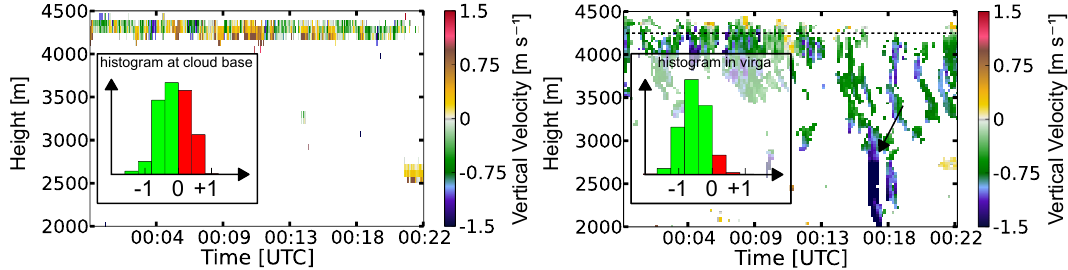
Figure 3. Vertical velocity for case 1. Left: derived from lidar (valid for more numerous smaller droplets at cloud base); right: derived from radar observations (valid for large particles; virgae).